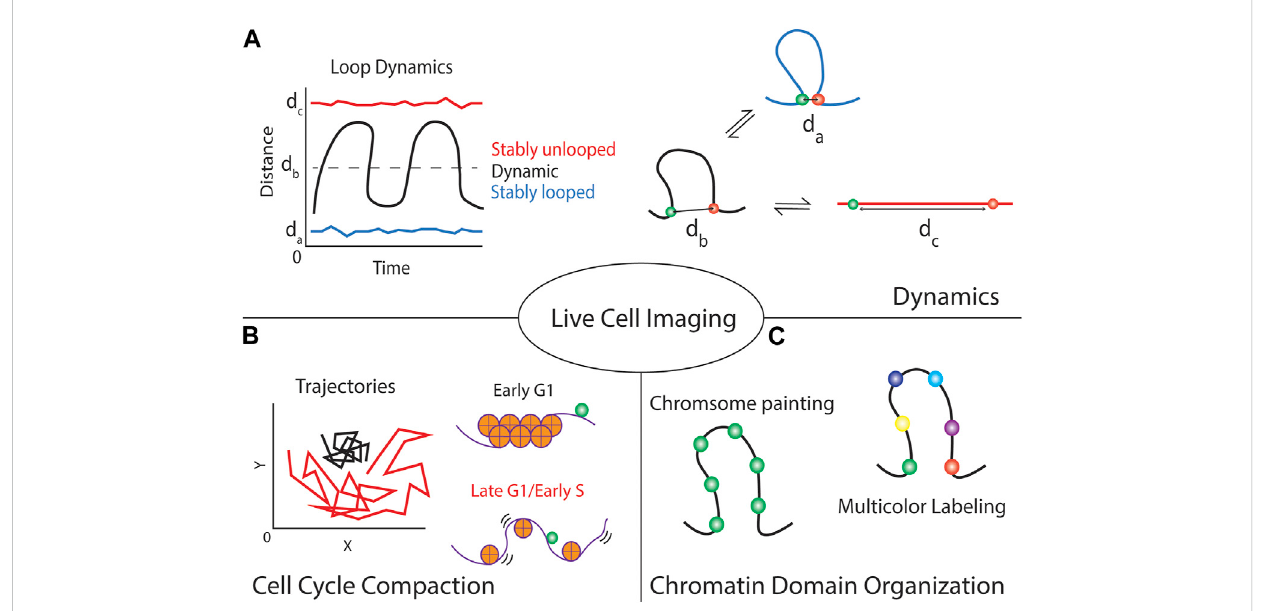
FIGURE 2 Live-cellCRISPRimagingofgenomiclociprovidesmultipleformsofinformationaboutthelocusandlocalchromatindomain. (A) Focusingonsingle cellscangivetemporaldynamicsaboutthelocalchromatinregion,usingdual-coloredtechniquescanshowiftheregionisstablyloopedorunloopedby maintaining a small or large spatial distance between the foci, respectively. Alternatively, it informs if the loop is continuously modulating its structure by large fl uctuations in the distance over time. (B) These techniques can indicate the local chromatin compaction by tracking the trajectories of the fl uorescentfociovertime.Highlypackedchromatin(e.g.,chromatininearlyG1phase)isgenerallymorestiffthusminimizinglocusmovementcompared to loosely packed chromatin (e.g., chromatin in late G1 or early S phase). (C) Although introducing multiple labels per chromosomal domain allows the visualization of the chromosome territory (chromosome painting), using a multicolor labeling strategy will provide the structural information in detail (multicolor